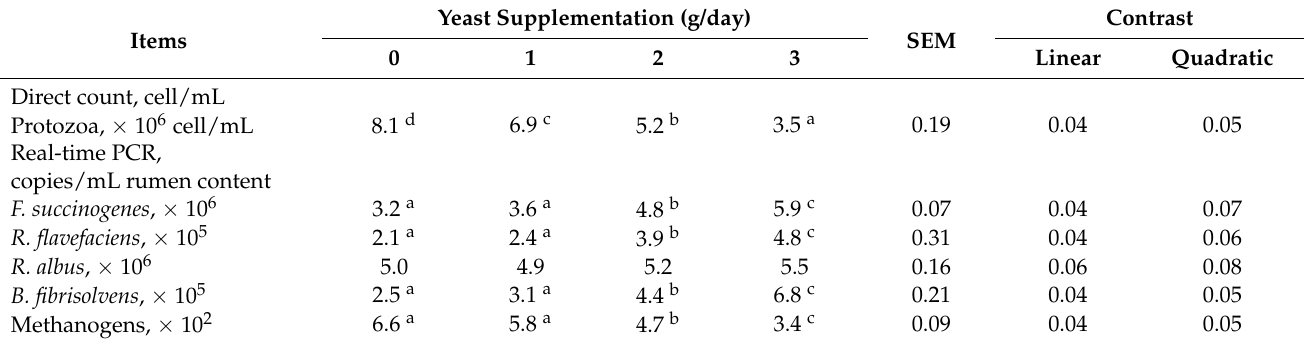
Table 4. Effect of yeast supplementation on microbial population in Thai native beef